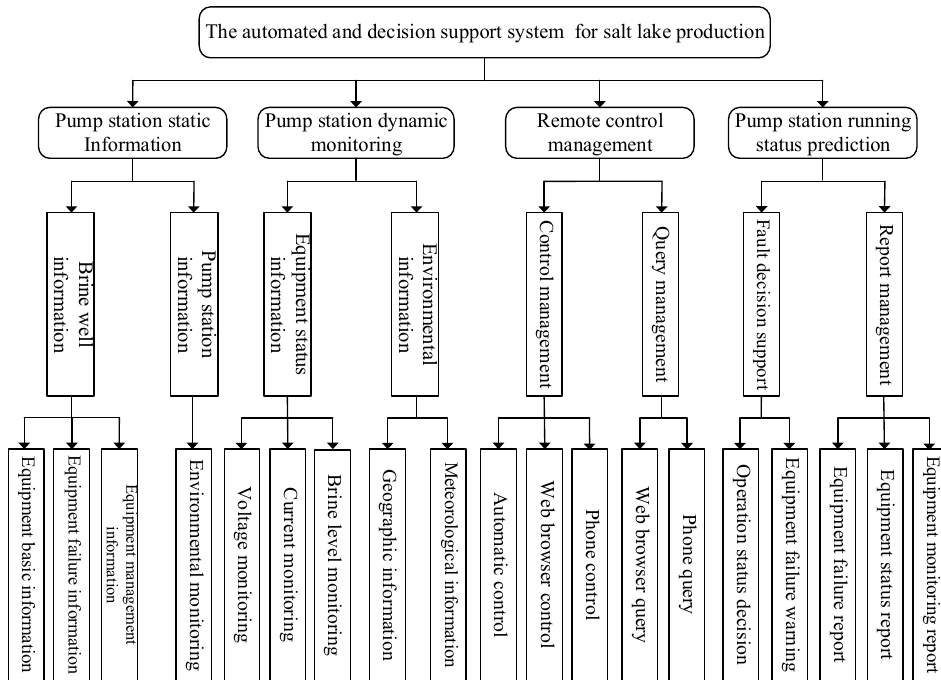
Figure 3. Functional framework of decision support system.